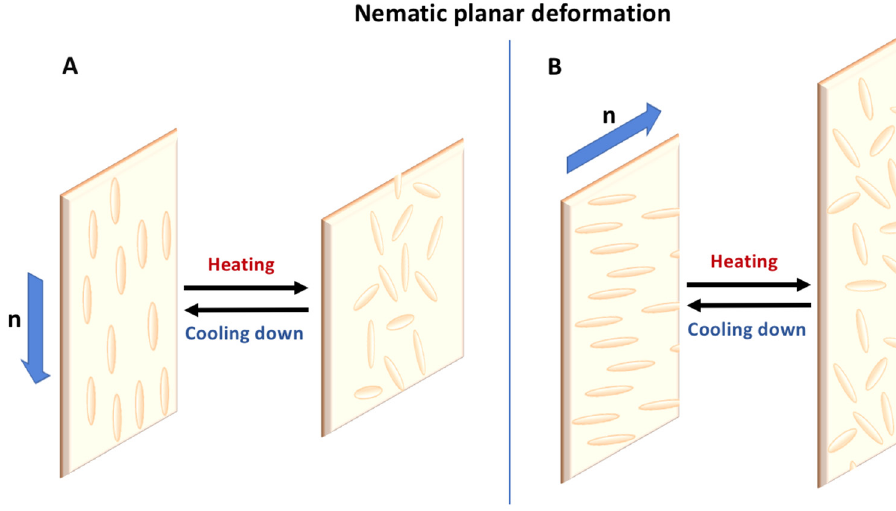
Figure 4. ( A , B ) Planar deformation with orientation programming of LC Figure 4. (A-B) Planar deformation with orientation programming of LC molecules.